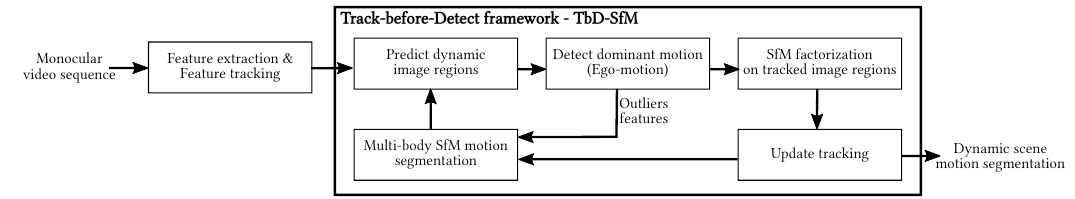
Figure 1. Motion segmentation with tracking